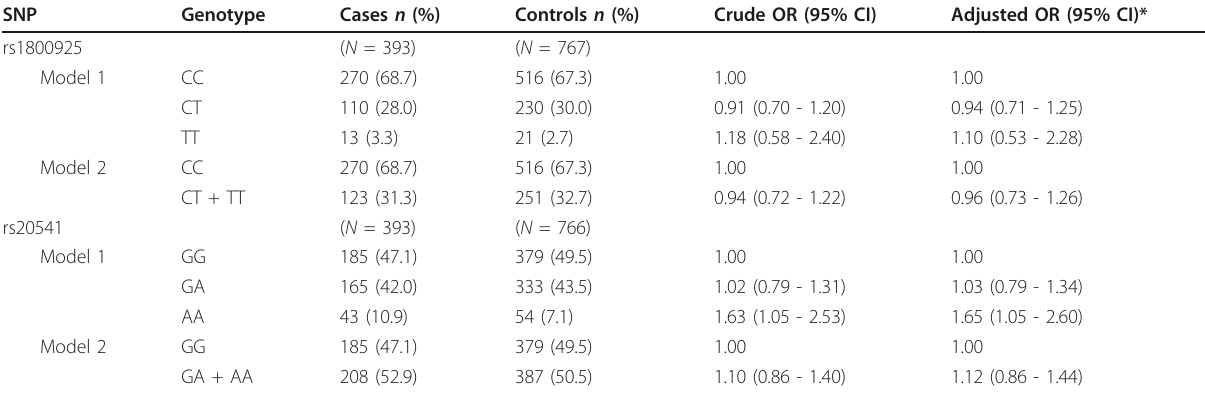
Table 2 Odds ratios (ORs) and 95% confidence intervals (CIs) for rhinoconjunctivitis according to IL13 polymorphisms in Japanese women, KOMCHS, Japan